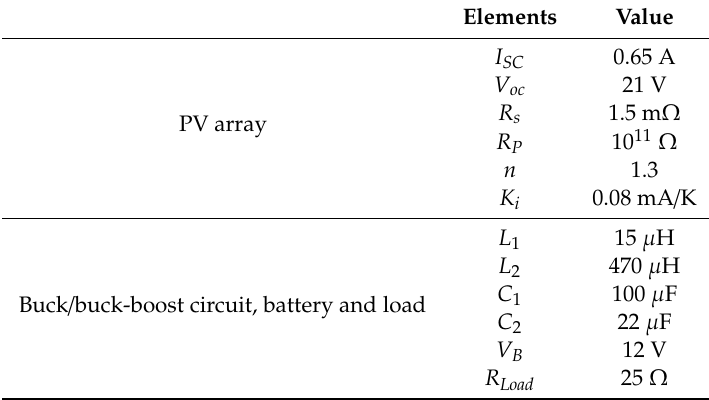
Table 1. Parameters of the solar PV energy harvesting